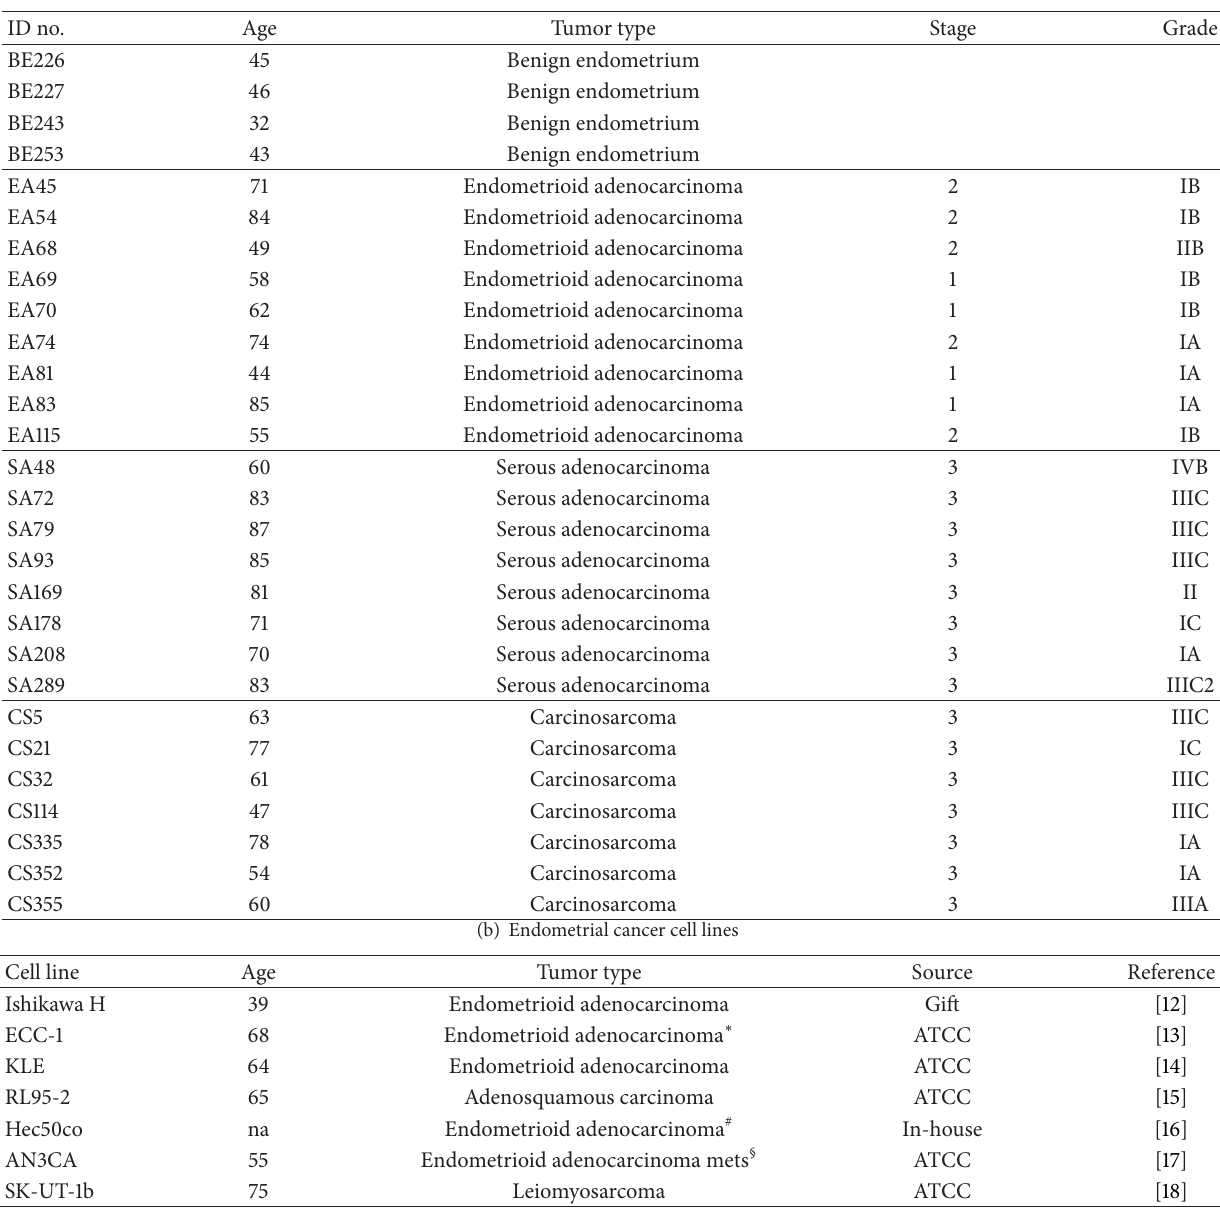
Table 1: Characteristics of the patients and cancer cell lines used in this study. (a) Endometrial cancer patient panel